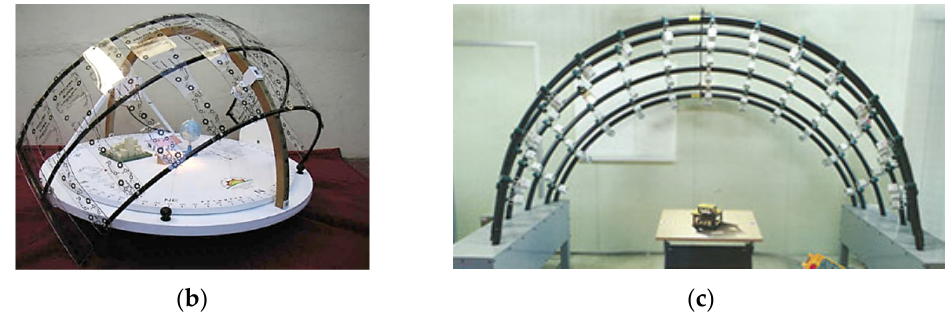
Figure 5. ( a ) Heliodon designed by Galvan et al. in 2005, ( b ) Heliodon with three solar trajectories designed in 2007, and ( c ) Heliodon with multiple solar trajectories designed in 2017.